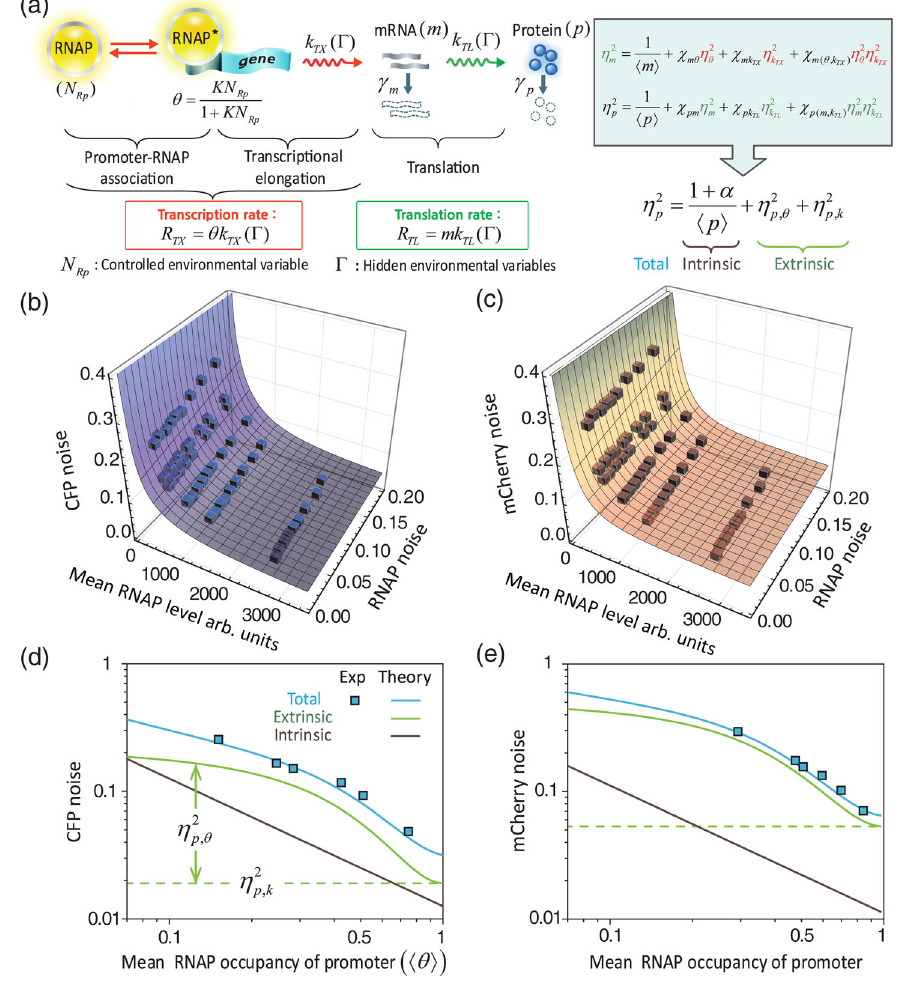
FIG. 3. Analyses of the gene expression variability in the synthetic E. coli with T7 RNAP driven transcription. (a) Our gene expression network model. RNAP bound fraction θ of promoter is explicitly modeled as a function of the number N which is under control in our system. For the model, the simple analytic result of the noise η 2 obtained, which has the same structure as Eq. (2b). (b),(c) The best global fit of Eq. (6) to the experimental data for the dependence of the protein noise on the mean RNAP level and RNAP noise. See Eq. (I1) for the explicit expression of Eq. (6) in terms of the control variables in the experiment. (d),(e) Dependence of protein noise on the mean RNAP occupancy of promoter. The protein noise comprises the intrinsic noise, ð 1 þ α Þ = h p i , and the extrinsic noise, η 2 environment-coupled fluctuations in θ and from that in k 0 . 1 (cid:3) 0 . 002 . The error bar or the standard deviation of each experimental result is obtained over 10 different samples, each of which contains about 1500 cells. The size of the error bar is smaller than or comparable to the symbol size (see Fig. 6 of Supplemental Material [32]). Details of the data analysis are presented in Appendix